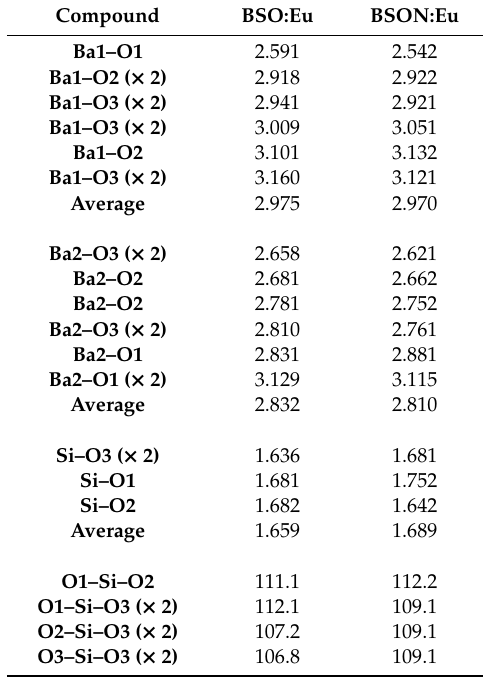
Table 2. Bond lengths (Å) and angles ( ◦ ) for BSO:Eu and